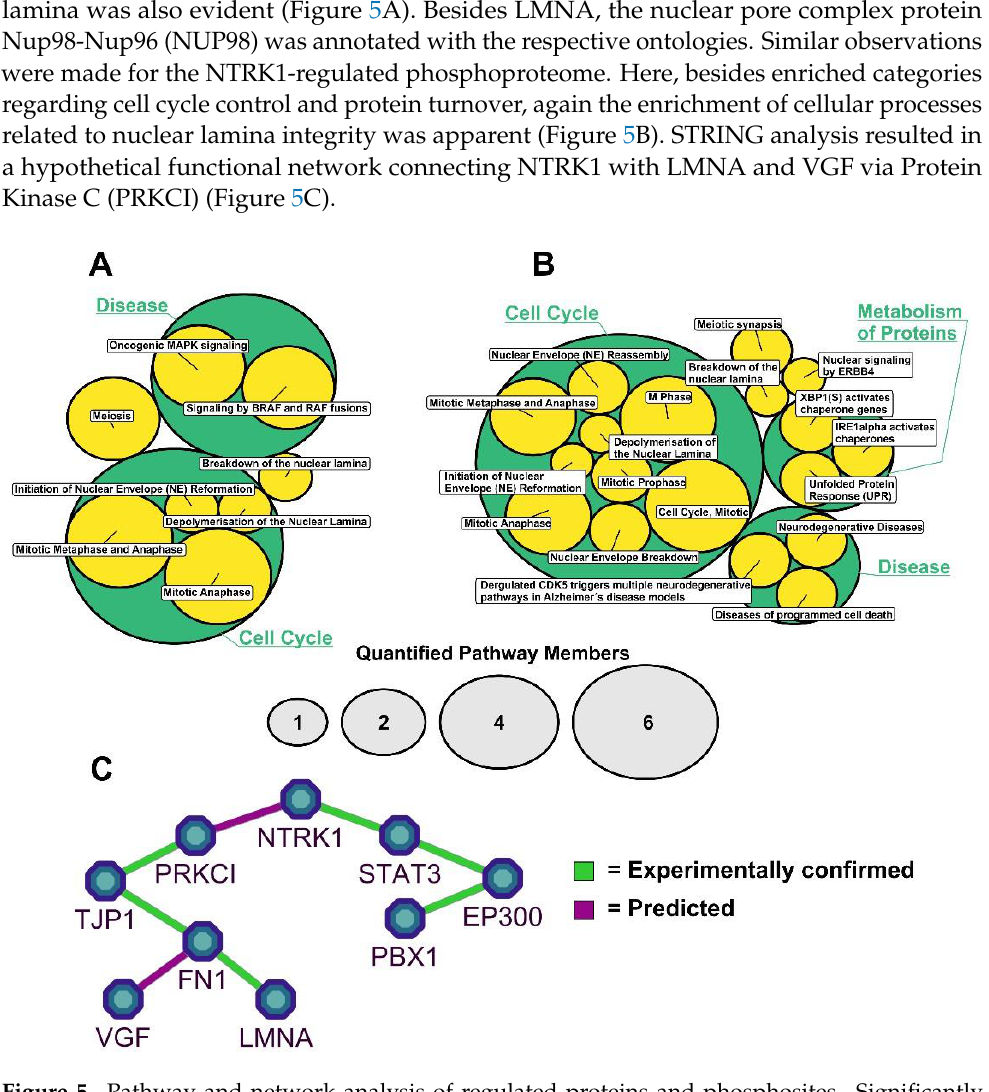
profiles of selected p-sites in NGF-treated cells (blue) compared to untreated controls (green). ( D ) Orthogonal validation of selected phosphorylation target sites shown in ( C ) using Western blot analyses of independent experiments. Cells were either treated with TET or a combination of TET/NGF for time points indicated to induce and activate NTRK1/TrkA, respectively. Phosphorylated states of NTRK1/TrkA, STMN1 and Lamin A/C and their regulation in relation to total protein expression are shown. Gapdh served as a loading control. Numbers indicate fold expression changes over time normalized to t = 0 h for each individual protein analyzed. Uncropped blots were added in Supplementary Materials.